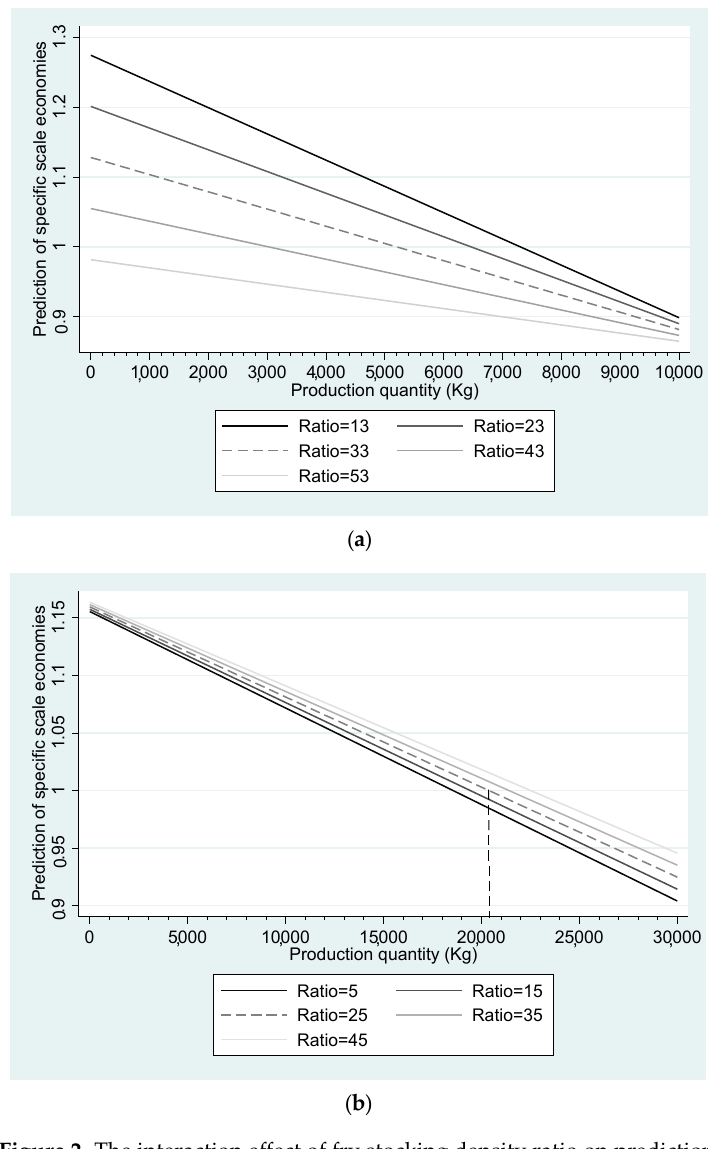
Figure 2. The interaction effect of fry stocking density ratio on prediction of specific scale economies in OWC and NOWC systems with low SMR. ( a ) Interaction effect of fry stocking density ratio on the prediction of specific scale economies in NOWCs of milkfish with low SMR. ( b ) Interaction effect of fry stocking density ratio on prediction of specific scale economies in OWCs of milkfish with SMR.